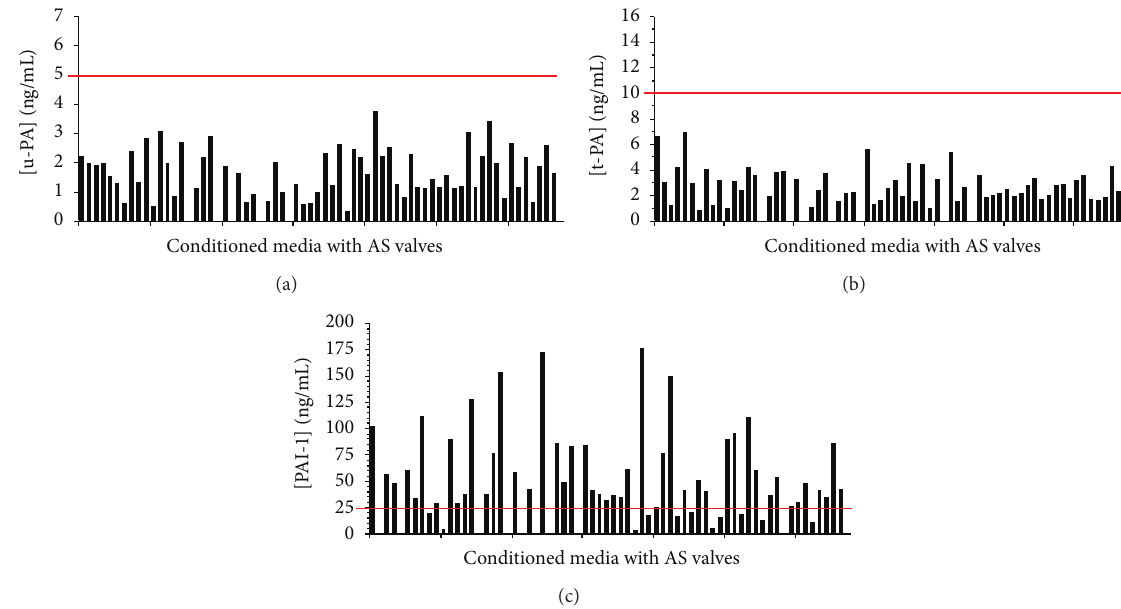
Figure 1: Concentrations of u-PA, t-PA, and PAI-1 in the conditioned media with aortic stenosis valves. All the aortic stenosis valves showed normal u-PA (a) and t-PA (b) concentrations, and forty-five valves showed elevated PAI-1 levels (c) when compared to the normal human plasma range according to the u-PA, t-PA, and PAI-1 microtiter ELISA device (the upper limit of which is shown as the red horizontal line at 5 ng/mL, 10ng/mL, and 25 ng/mL, for u-PA, t-PA, and PAI-1 resp.). AS: aortic stenosis.